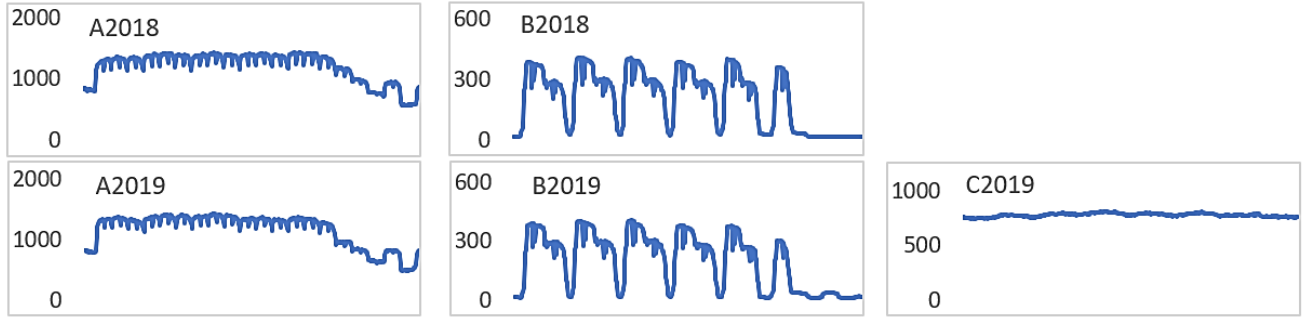
Figure 1. Comparison of the average weekly power demand profiles in [kW] for an annual period. Table 3. Statistical data of the 15 min load power time series of the